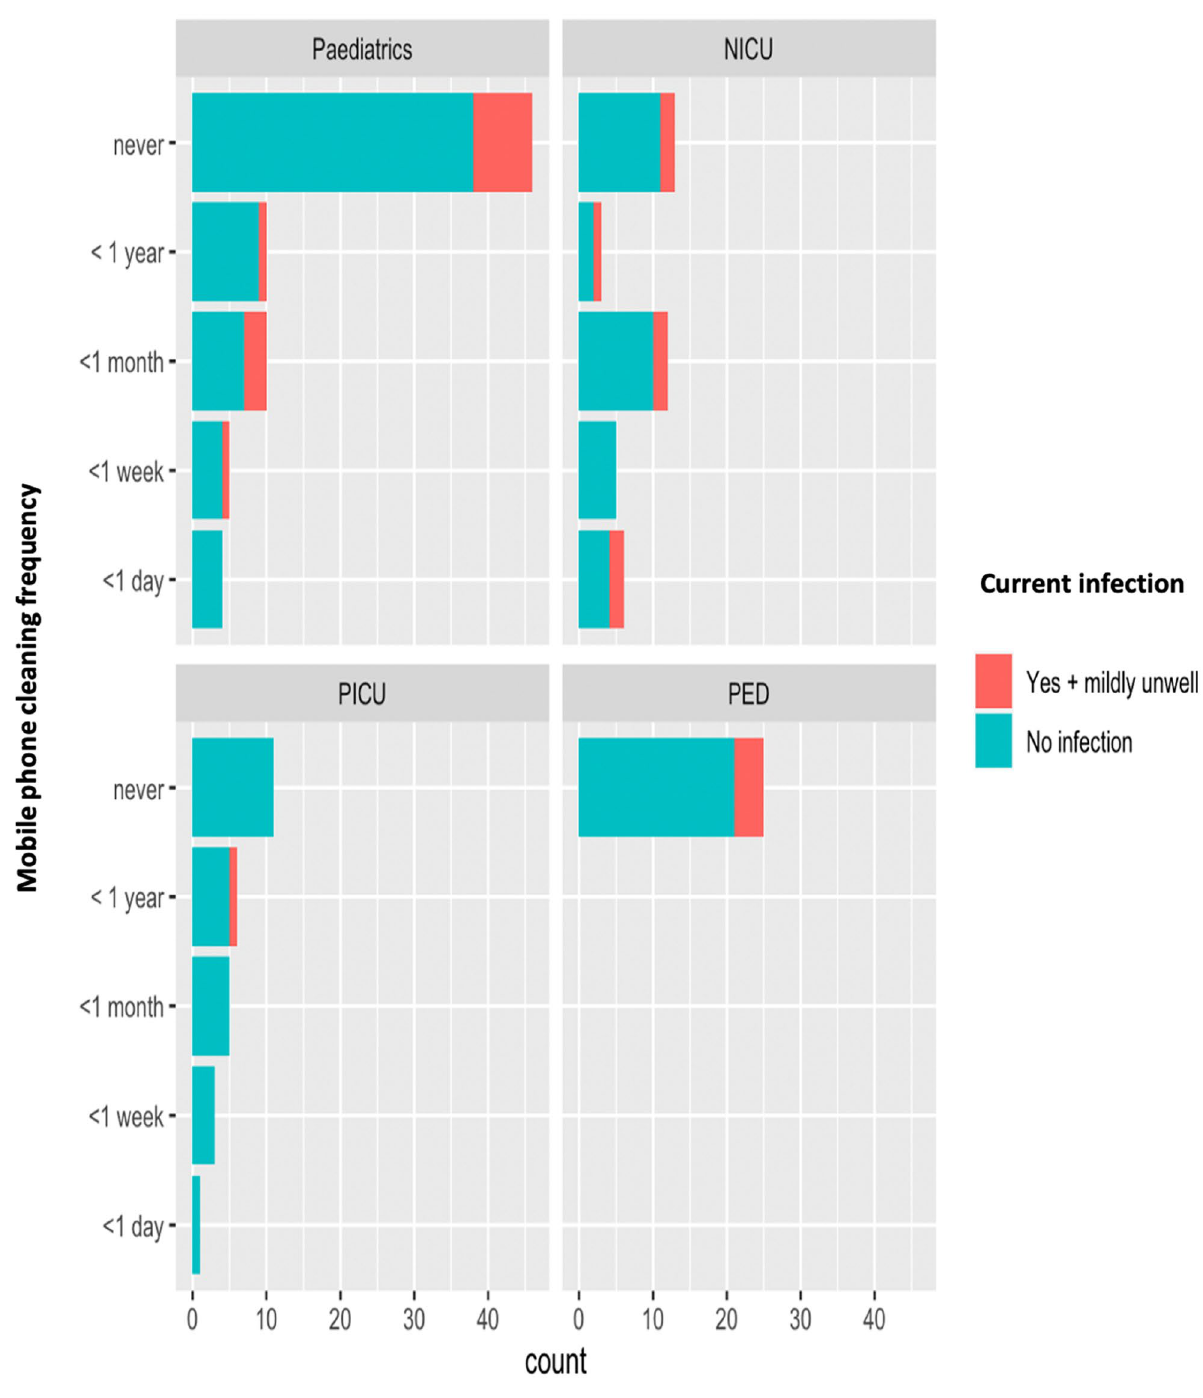
Figure 6. Comparison of mobile phone cleaning frequency and whether healthcare workers (medical staff and non-medical staff) self-reported to be suffering from an infection across four different hospital wards (General Paediatrics, Neonatal Intensive Care Unit, Paediatric Intensive Care Unit, Paediatric Emergency